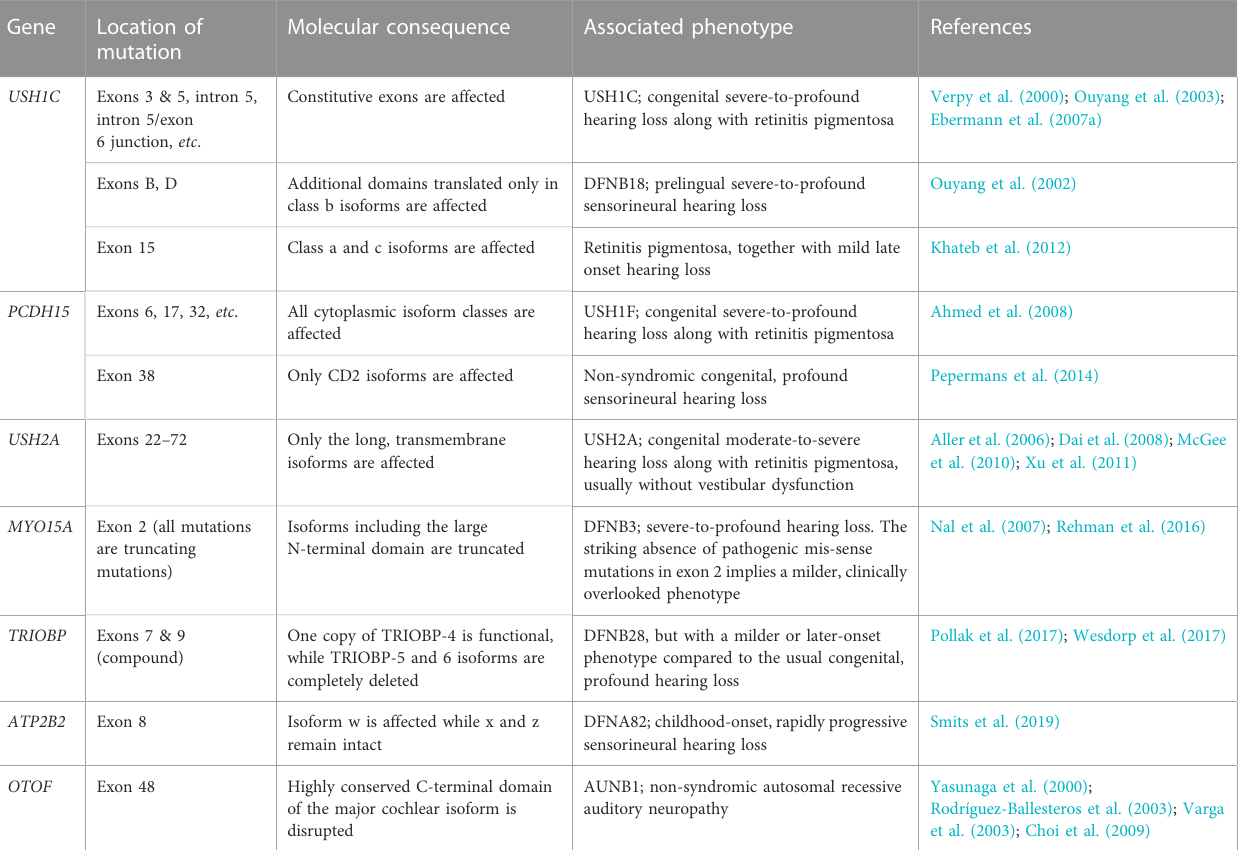
TABLE 1 Mutations associated with hearing loss that affect speci fi c splice